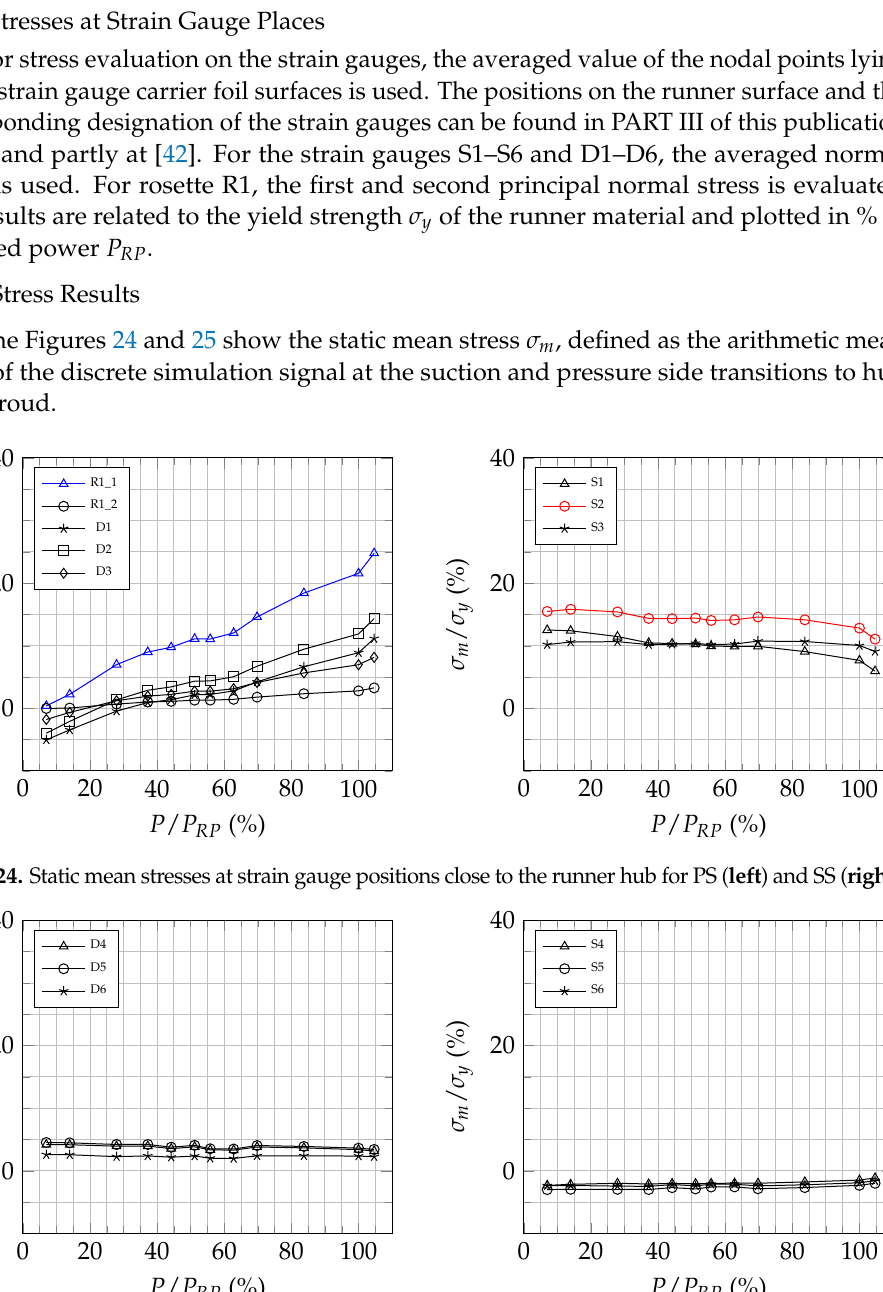
Figure 25. Static mean stresses at strain gauge positions close to the runner shroud for PS ( left ) and SS ( right